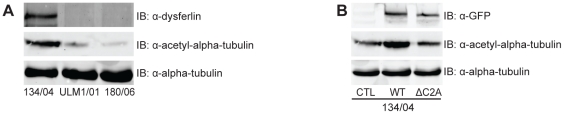
Dysferlin expression increases alpha-tubulin acetylation in muscle cells.(A) 134/04, 180/06 and ULM1/01 cell lysates were immunoblotted with anti-dysferlin and anti-acetylated alpha-tubulin antibodies. Alpha-tubulin was used as a loading control. (B) GFP-dysferlin wildtype (WT) or GFP-dysferlinΔC2A (ΔC2A) were transfected into 134/04 myoblasts. Transfected and untransfected (CTL) cell lysates were separated by SDS-PAGE and immunoblotted with the indicated antibodies.